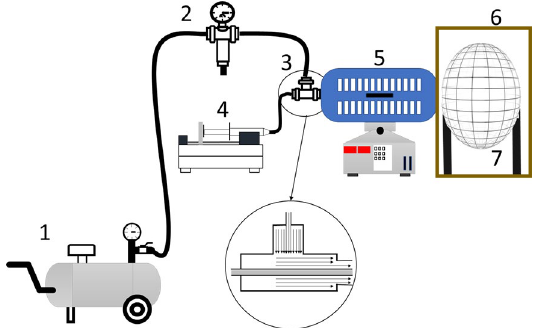
Figure 1. Schematic representation of the Solution Blow Spinning process: 1) Pressurized air 2) Manometer 3) Nozzle 4) Injection pump 5) Tubular furnace 6) Heated chamber 7)